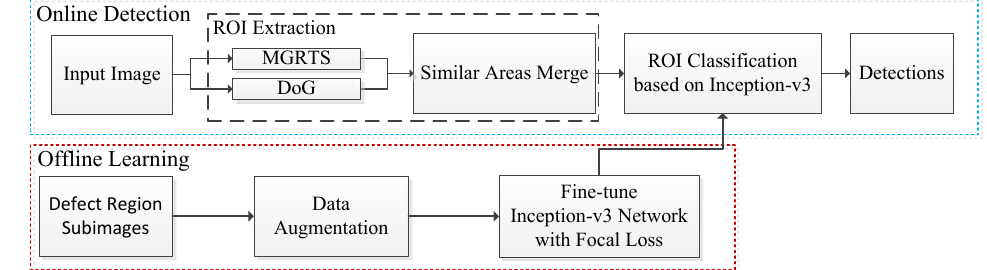
Figure 4. Overview of the defect detection method applied to a real production line. DOG: Difference of Gaussian, MGRTS: mask gradient response-based threshold segmentation, ROI: region of interest.